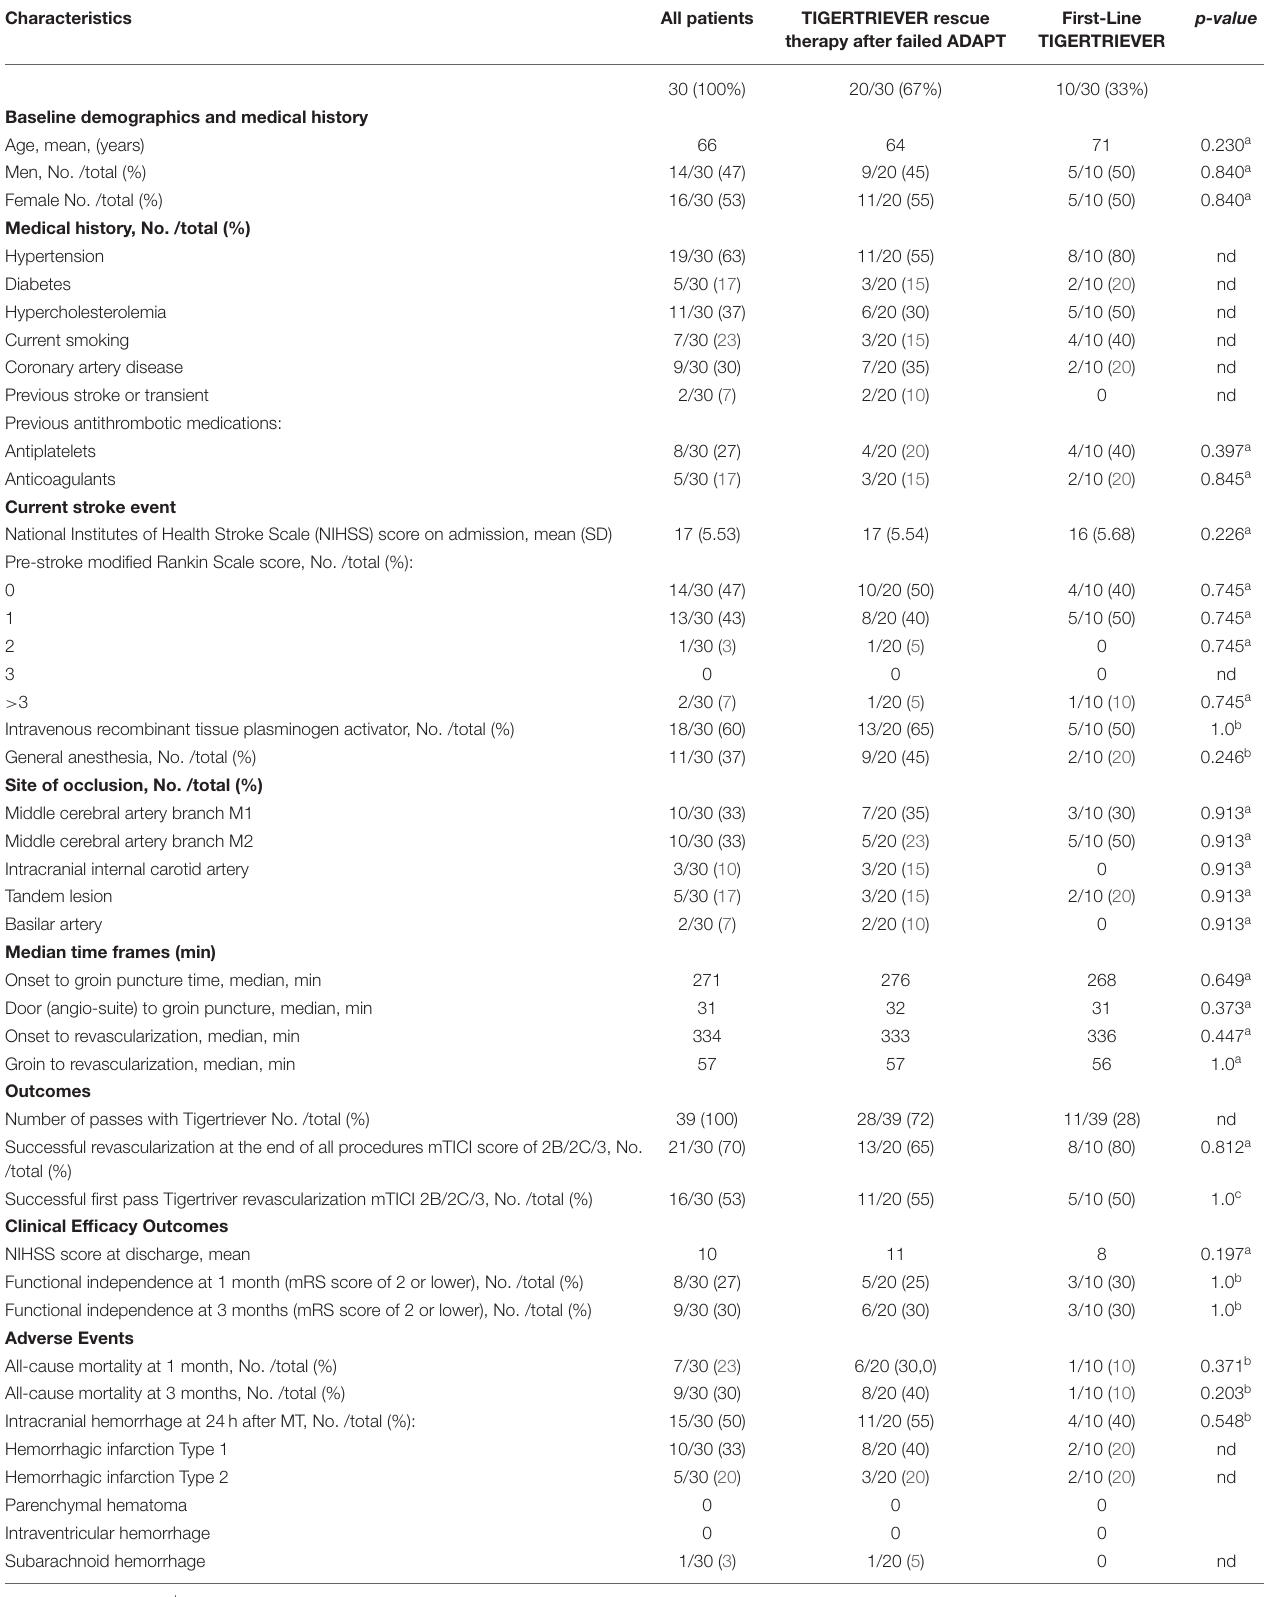
TABLE 1 | Patient characteristics.